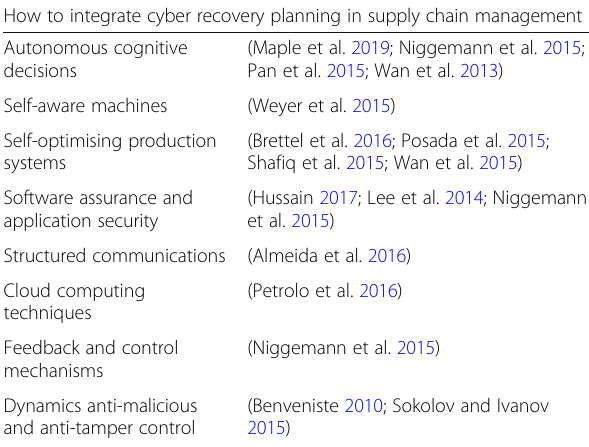
Table 5 How to integrate cyber recovery planning in supply chain management How to integrate cyber recovery planning in supply chain management